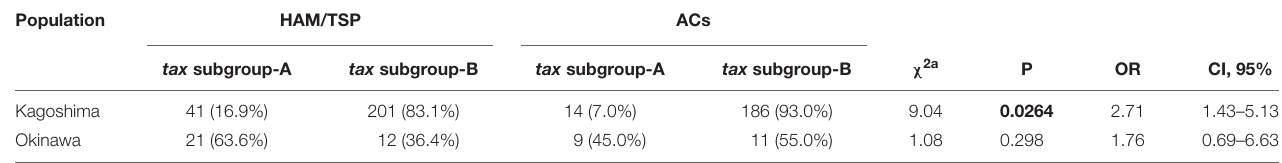
a Reported as one-tailed with Yates correction. Odds ratio used the approximation of Woolf. The significant value is indicated in bold. OR, Odds ratio; CI, confidence interval; HAM/TSP, HTLV-1-associated myelopathy/tropical spastic paraparesis; ACs, asymptomatic carriers.